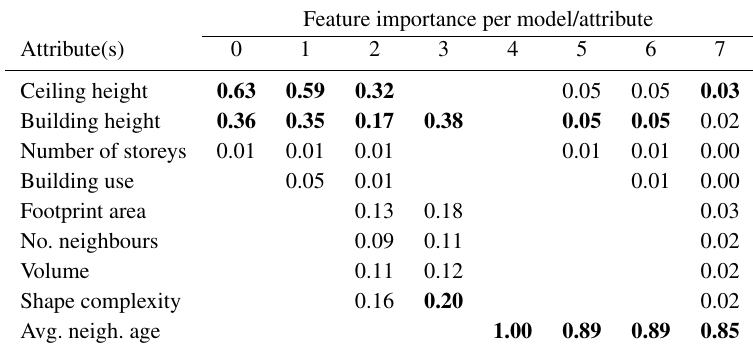
Table 2. Feature importance in the eight considered scenarios. The two most important variables in each model are emphasised.